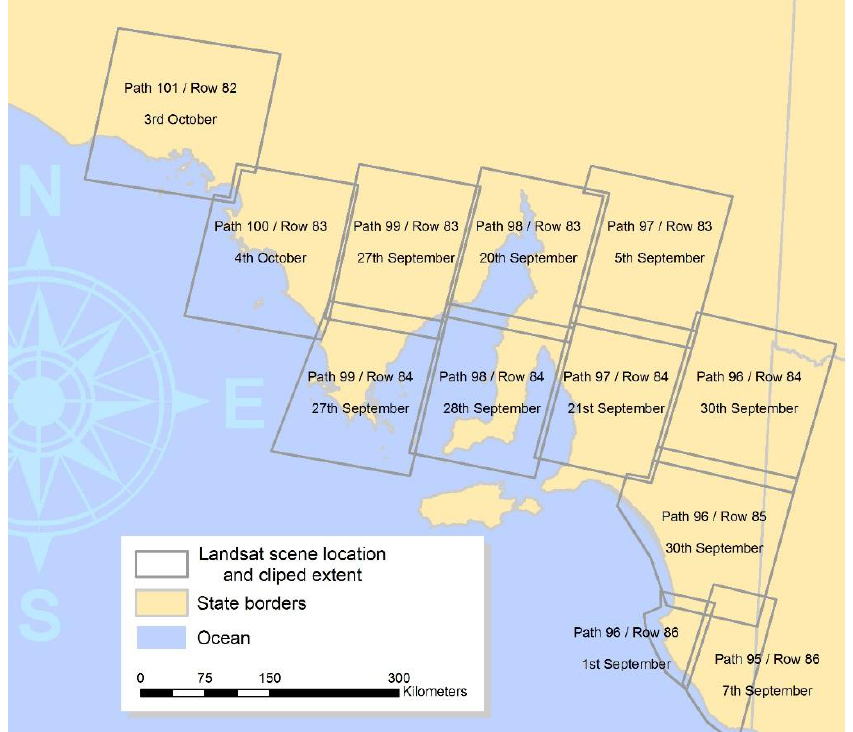
Figure A2. Mosaicked Landsat scene dates for the 2005 growing season.